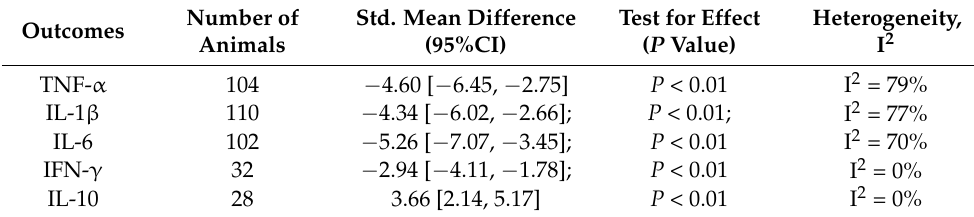
Table 2. The efficacy of MSC-EV therapy on inflammatory